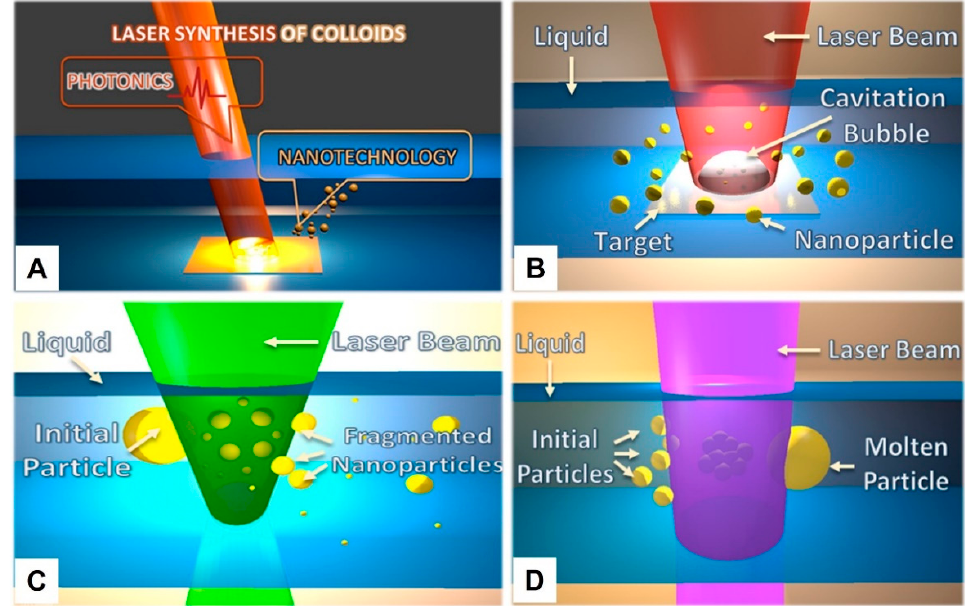
Figure 1. Classification scheme of pulsed laser heating in liquid medium. ( A ) Pulsed laser synthesis of colloids. ( B ) Pulsed laser ablation in liquids (PLAL). ( C ) Pulsed laser fragmentation in liquids (PLFL). ( D ) Pulsed laser melting in liquids (PLML). Reprinted with permission from Ref. [29].